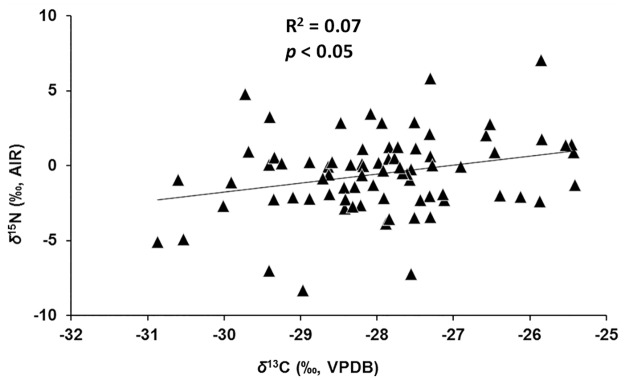
Foliar carbon and nitrogen isotopic compositions of all plant samples.There is a weak, positive correlation between δ13C and δ15N (see text).